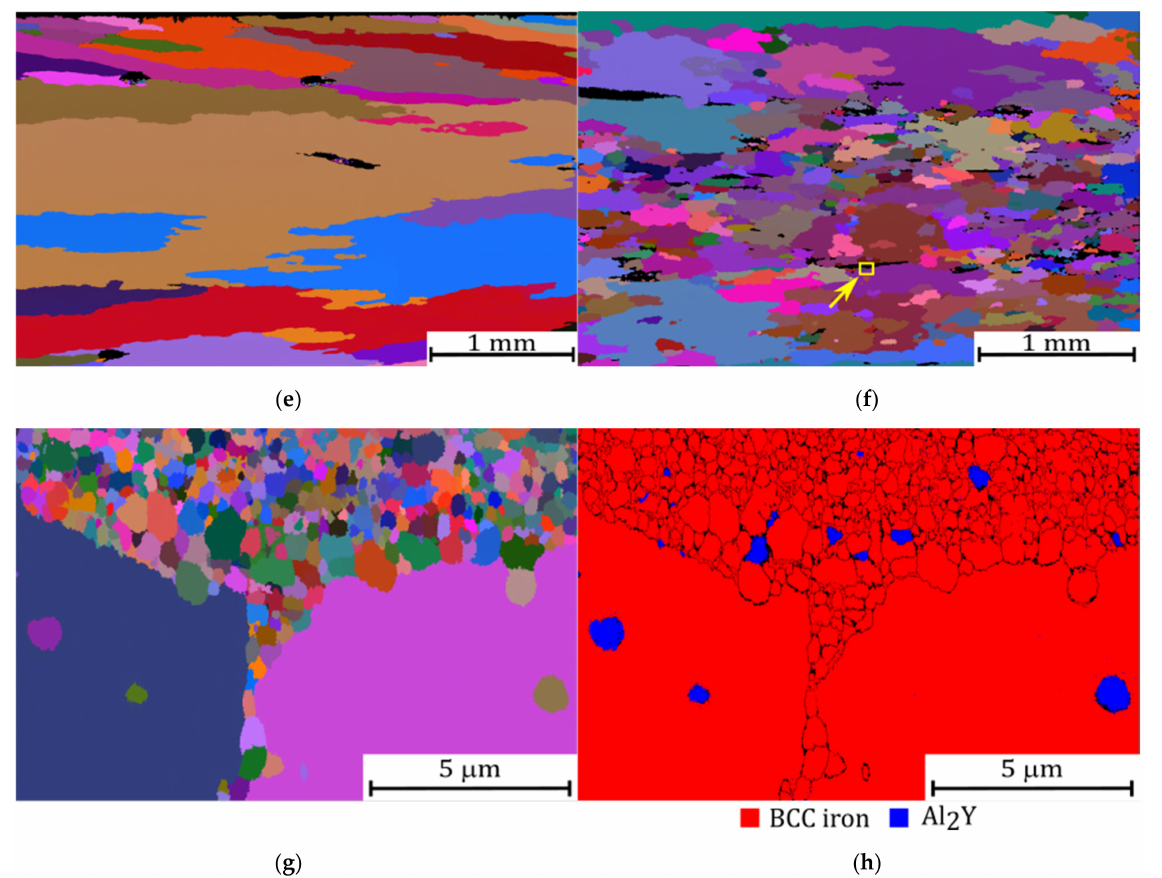
Figure 3. Euler color EBSD maps of grain microstructure for Fe-10Al-4Y 2 O 3 ODS alloys with ( a ) 0,